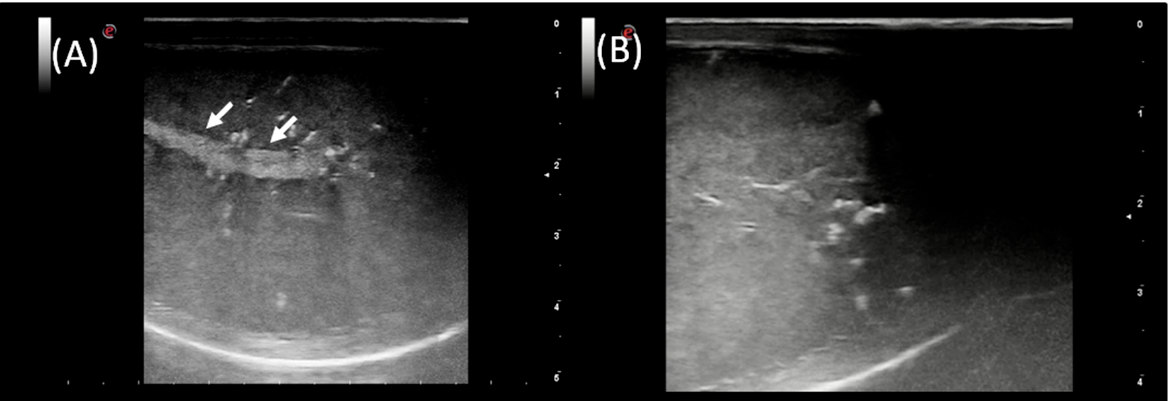
Figure 3. Gray-scale ultrasound images of testicular parenchyma in sagittal view ( A ) and longitudinal view ( B ) in the ram. The hyperechogenic mediastinum testis was marked with white arrows.